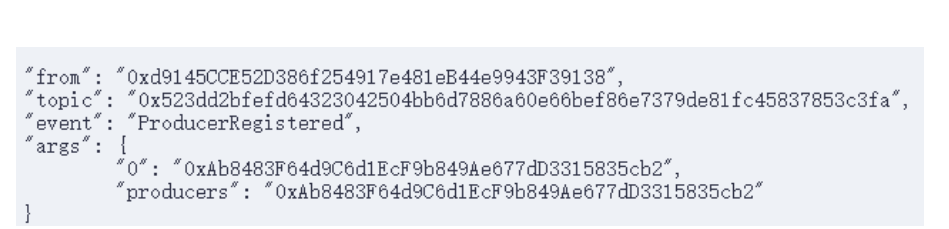
Figure A1. Successful execution of UserRegister Function.